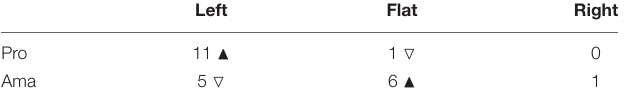
Frontiers in Psychology |